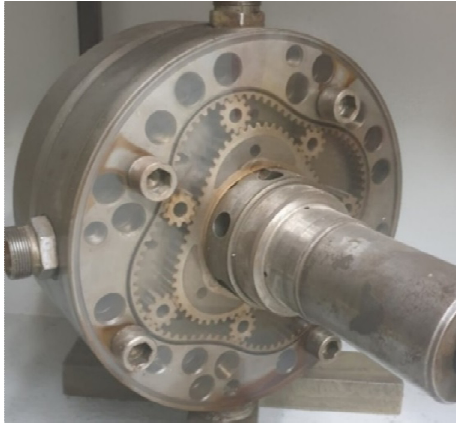
Figure 2. Satellite hydraulic motor by Hydroster.